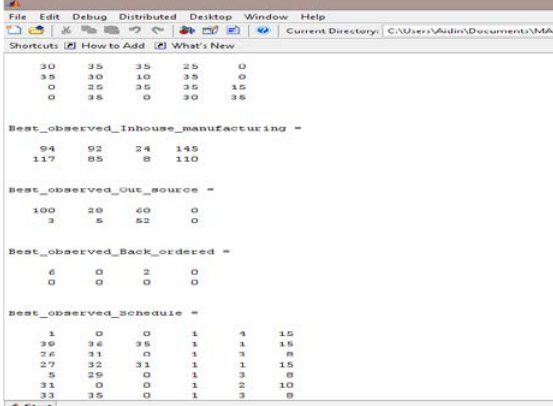
Fig. 16. Results of in-house manufacturing, outsourcing and back orders achieved in final solution of experiment 1